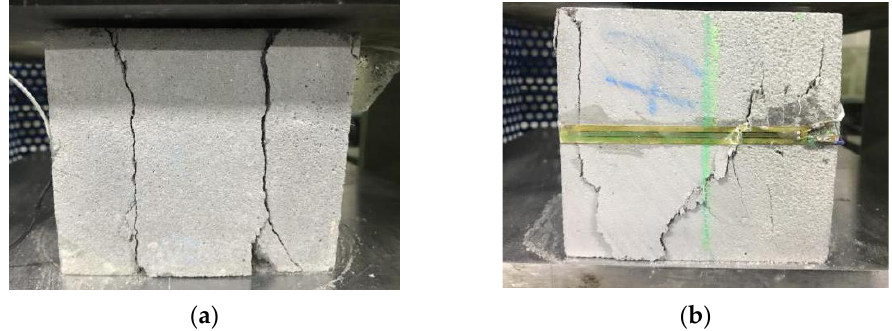
Figure 16. The printed cube sample cracks of ( a ) A and ( b ) reverse